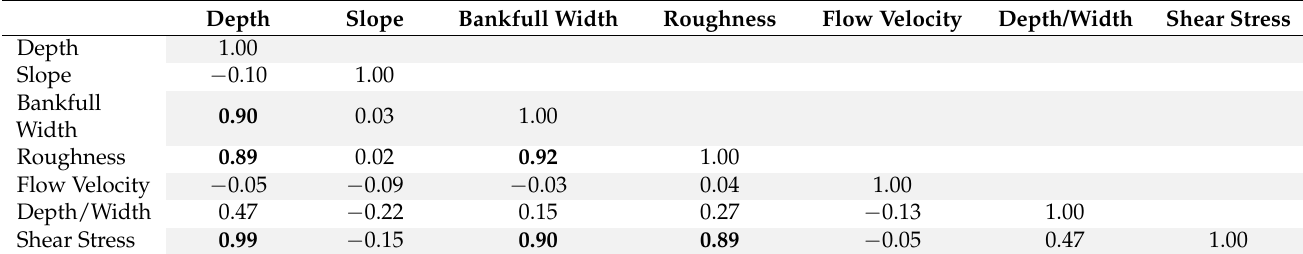
Table 4. Spearman correlation coefficients (r spearman > 0.7 in bold) between morphological factors.